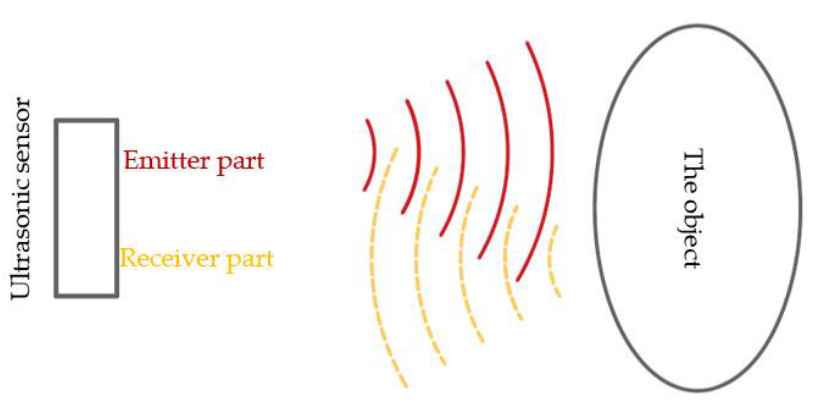
Figure 2. The principle behind distance measurement with sonar sensors.